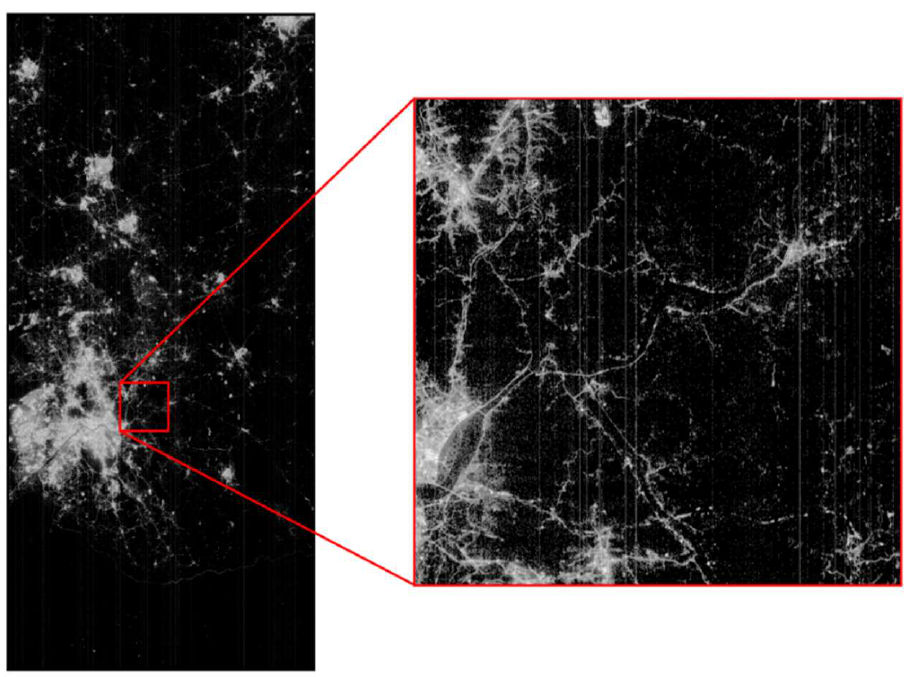
Figure 1. A GI image (B1 band) with apparent stripes. The image has been processed by logarithmic stretching for better visualizations.